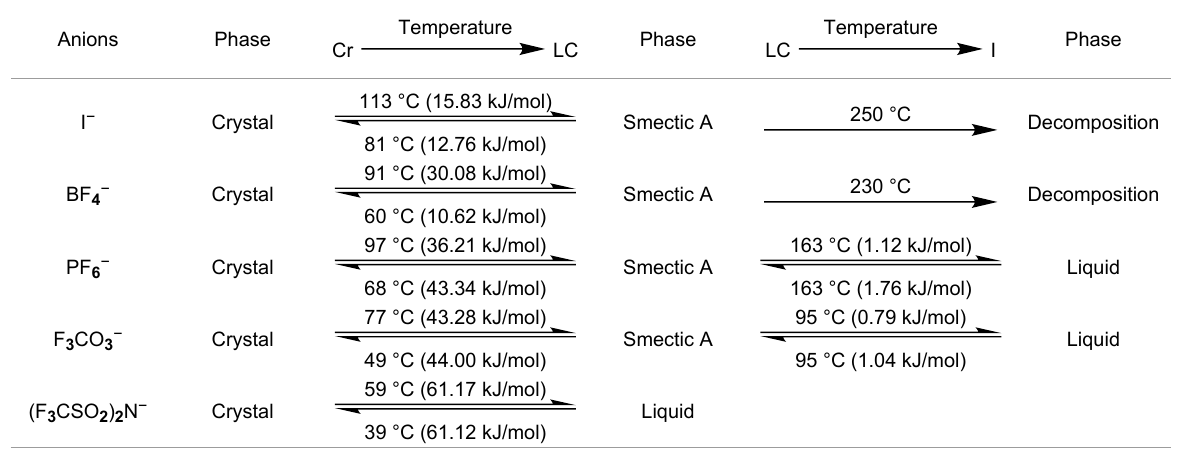
Table 2: Phase transition temperatures and corresponding enthalpies determined from the 2 nd heating and cooling.